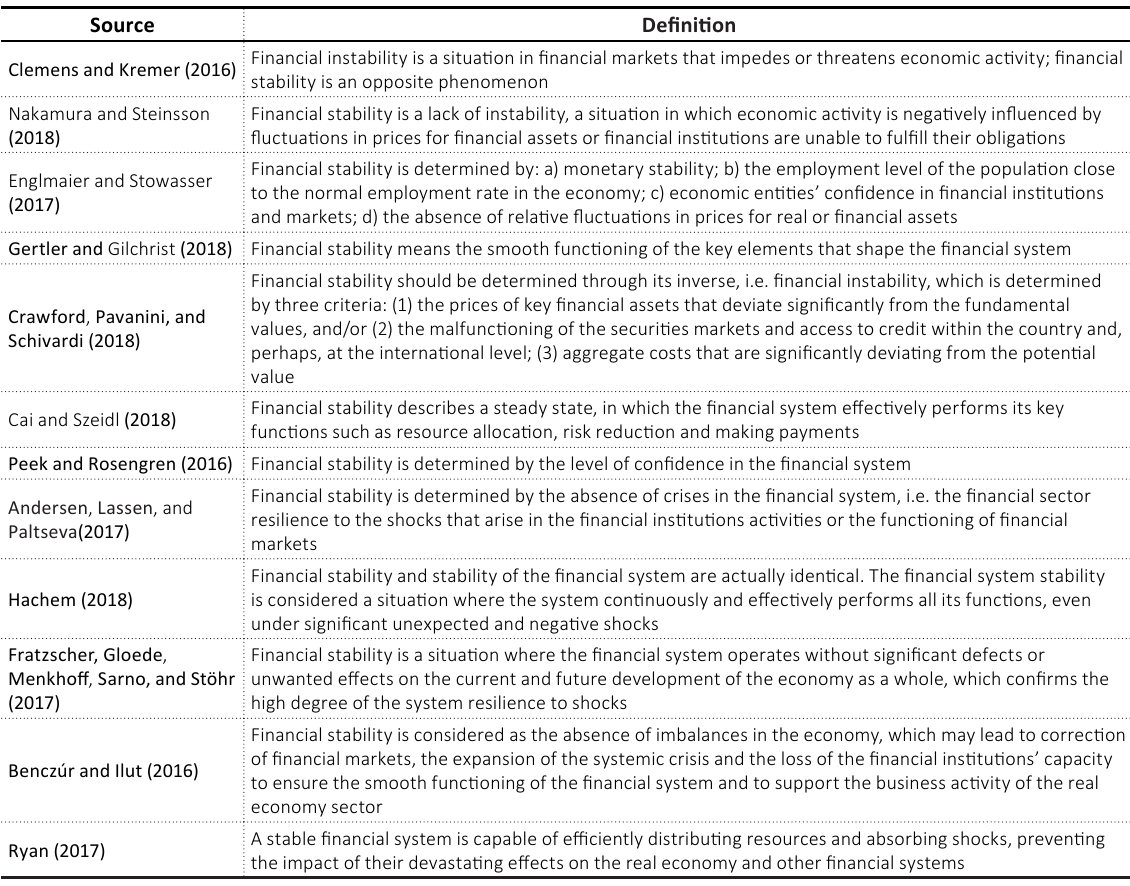
Source: Developed by the